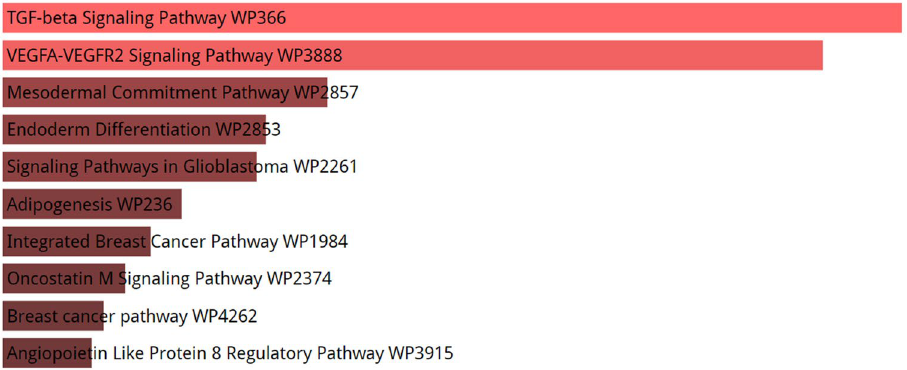
Figure 2. Enrichment analysis of genes which are predicted to be targeted by enoxacin-induced miRNAs. The Panther enrichment analysis using Enrichr showed that genes putatively targeted by enoxacin-induced miRNAs were mostly involved in TGF-β signaling (p-value = 5.782e−20). The lighter the red color is, the more significant the